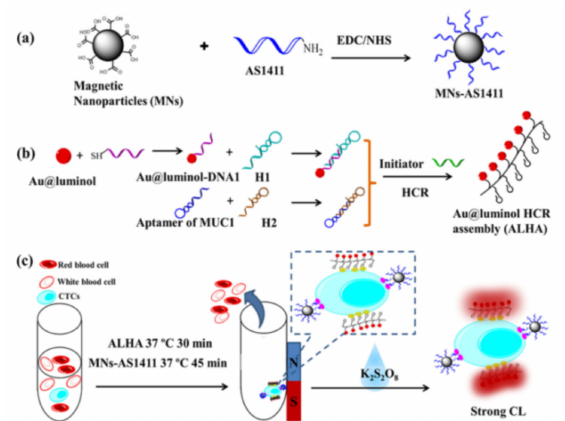
Figure 7. Schematic of experimental process: ( a ) Preparation of AS1411 modified Fe 3 O 4 nanoparticles (MNs-AS1411), ( b ) Preparation of Au@luminol-HCR assembly (ALHA) and ( c ) Specific recogni- tion, isolation and CL detection of CTCs by MNs-AS1411/ALHA system [127]. Copyright 2020 Elsevier B.V. Table 1. Analytical performances of various nanomaterials-based optical techniques for CTCs detection. Detection